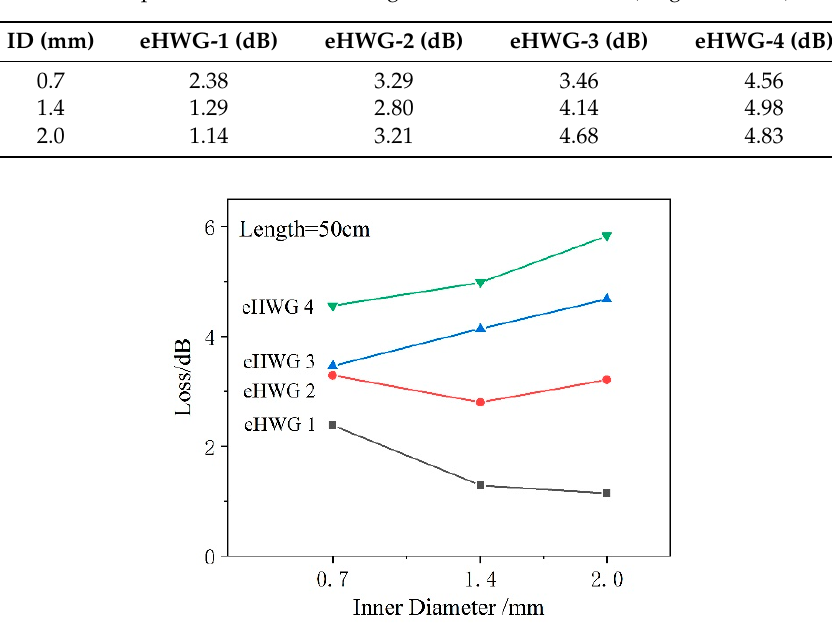
Figure 6. Spectra losses of eHWGs with a waveguide with various IDs.